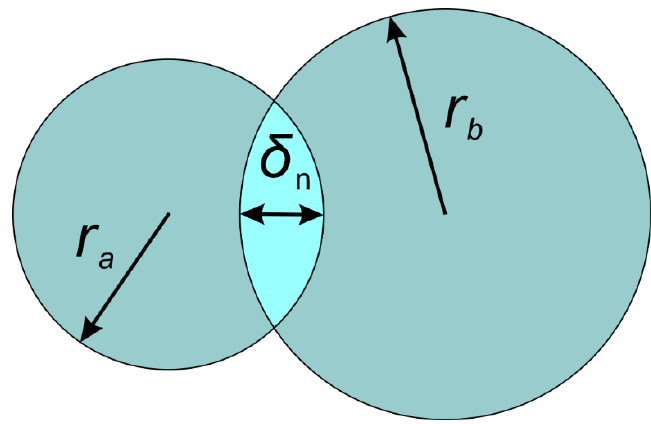
Figure 1. The sketch of two contact particles.